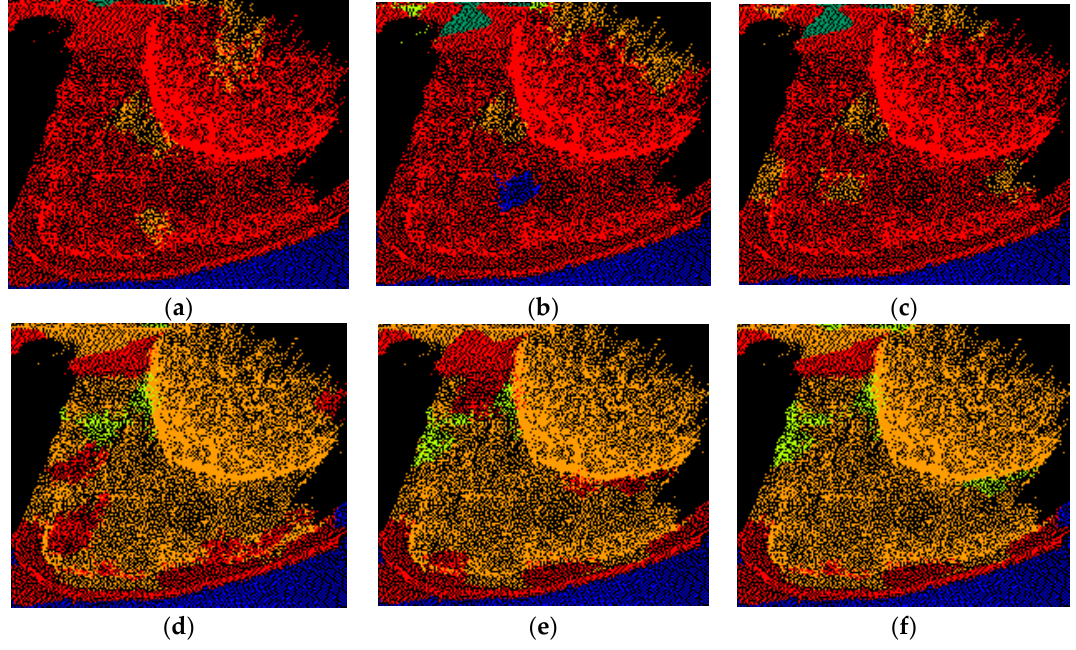
Figure 7. Examples of the misclassification of curbs with different feature sets: ( a ) Geo, ( b ) Geo & I, ( c ) Geo & CI, ( d ) Geo & C, ( e ) Geo & C & OI, ( f ) Geo & C & CI.